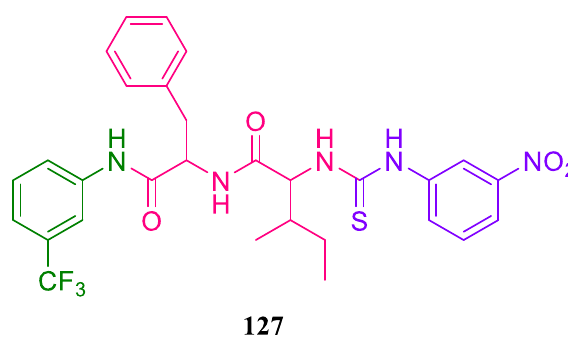
Figure 104. Terminal functionalised dipeptide derivatives.